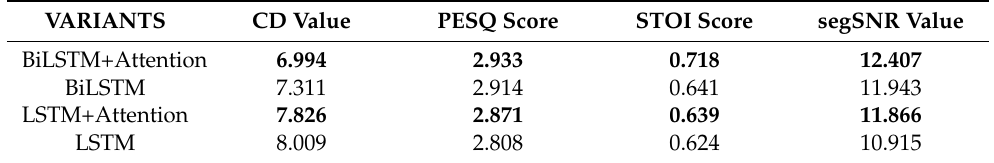
Table 3. Performance comparison between different variants on the PC speaker esophageal corpus test